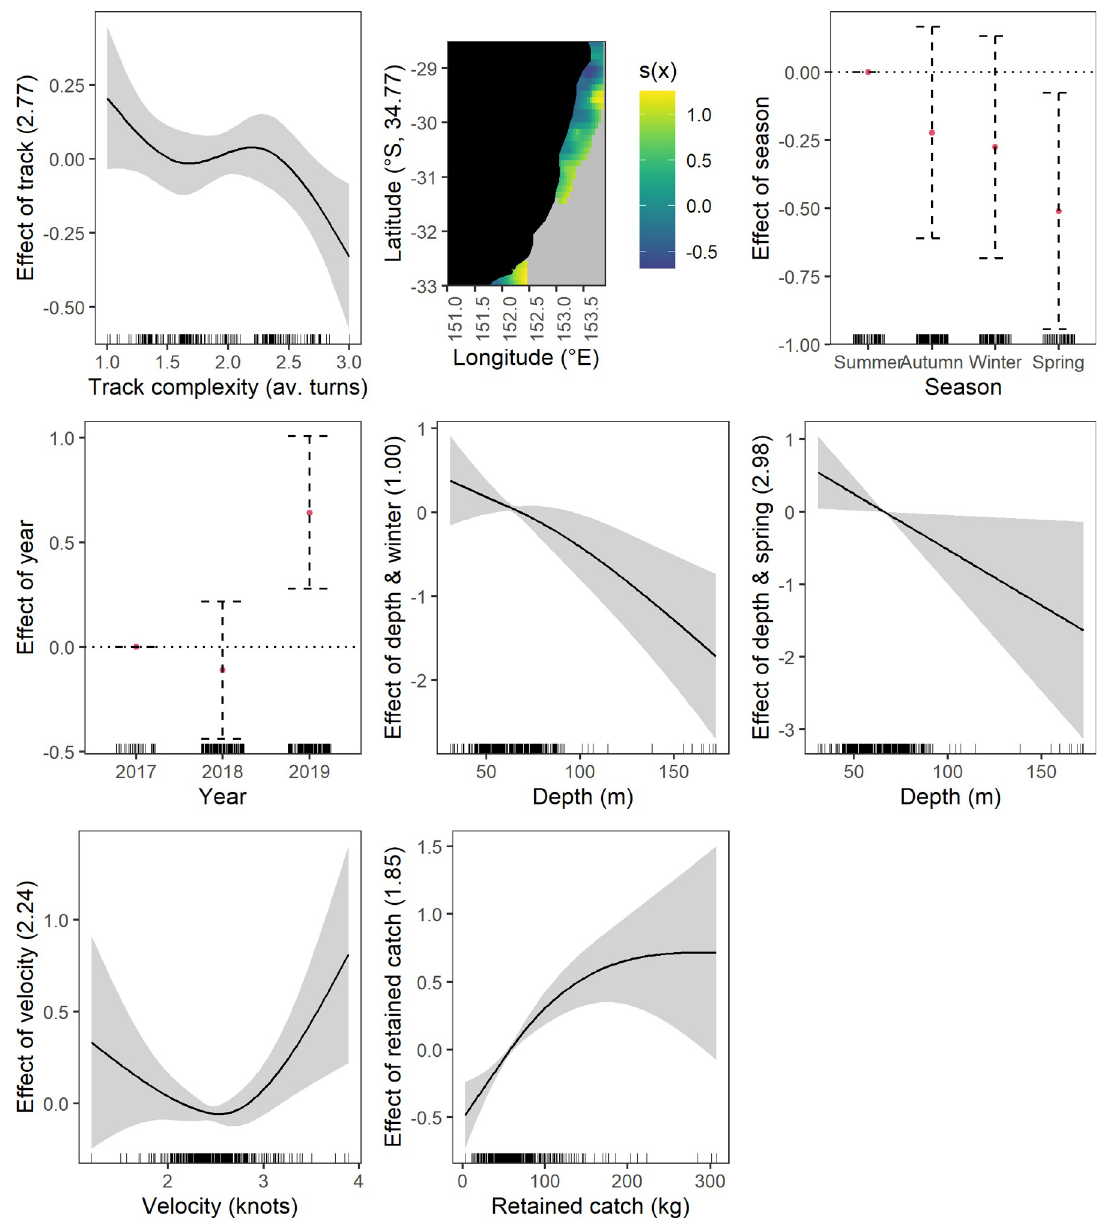
Fig 6. Significant effects plots from the discarded commercial fish response generalised additive mixed models, shaded area represents the 95% confidence limits whilst the surfaces represent the effect of 2-d smoothing on spatial coordinates. demersal trawl fisheries (e.g. [6], Table 4). The relationship between the discarding of fish and latitude is simple, partly due to the lack of interaction with longitude, and shows a north to south negative gradient. It is feasible that the relationship could be underpinned by the increase in fish species richness and abundance in a northerly direction due to the increase in water temperature and habitat diversity [55,56]. The finding is supported by the northern zone in the present study recording 33 more species than the southern zone (see Table 2) and the East Coast Prawn Trawl fishery (QLD EKP fishery component) discarding more fish on a lower latitude section of the same coastline [10]. Latitude and longitude interacted to affect the